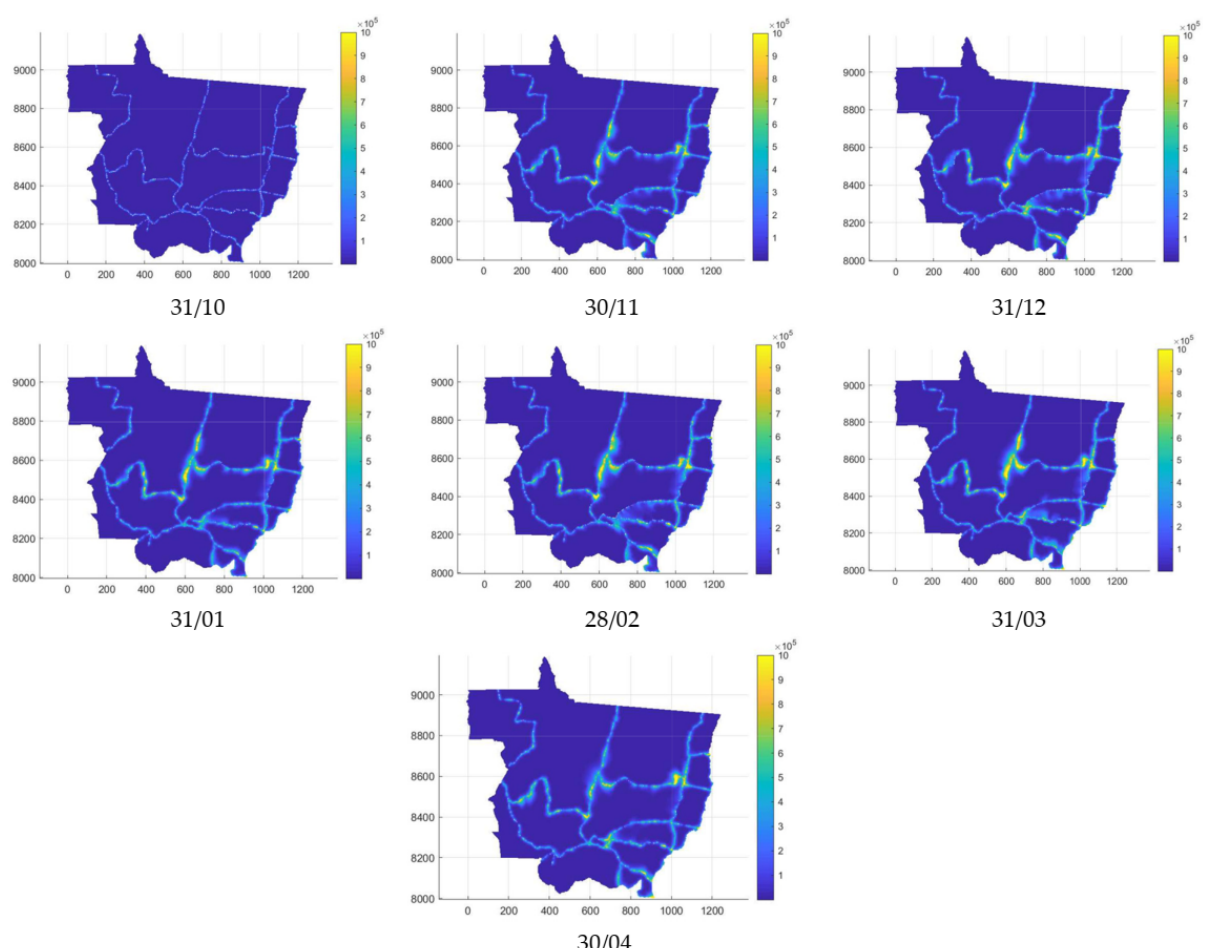
Figure 4. Spore concentrations per km 2 for the last day of the month throughout the 2018/2019 harvest (October, November, December, January, February, March,